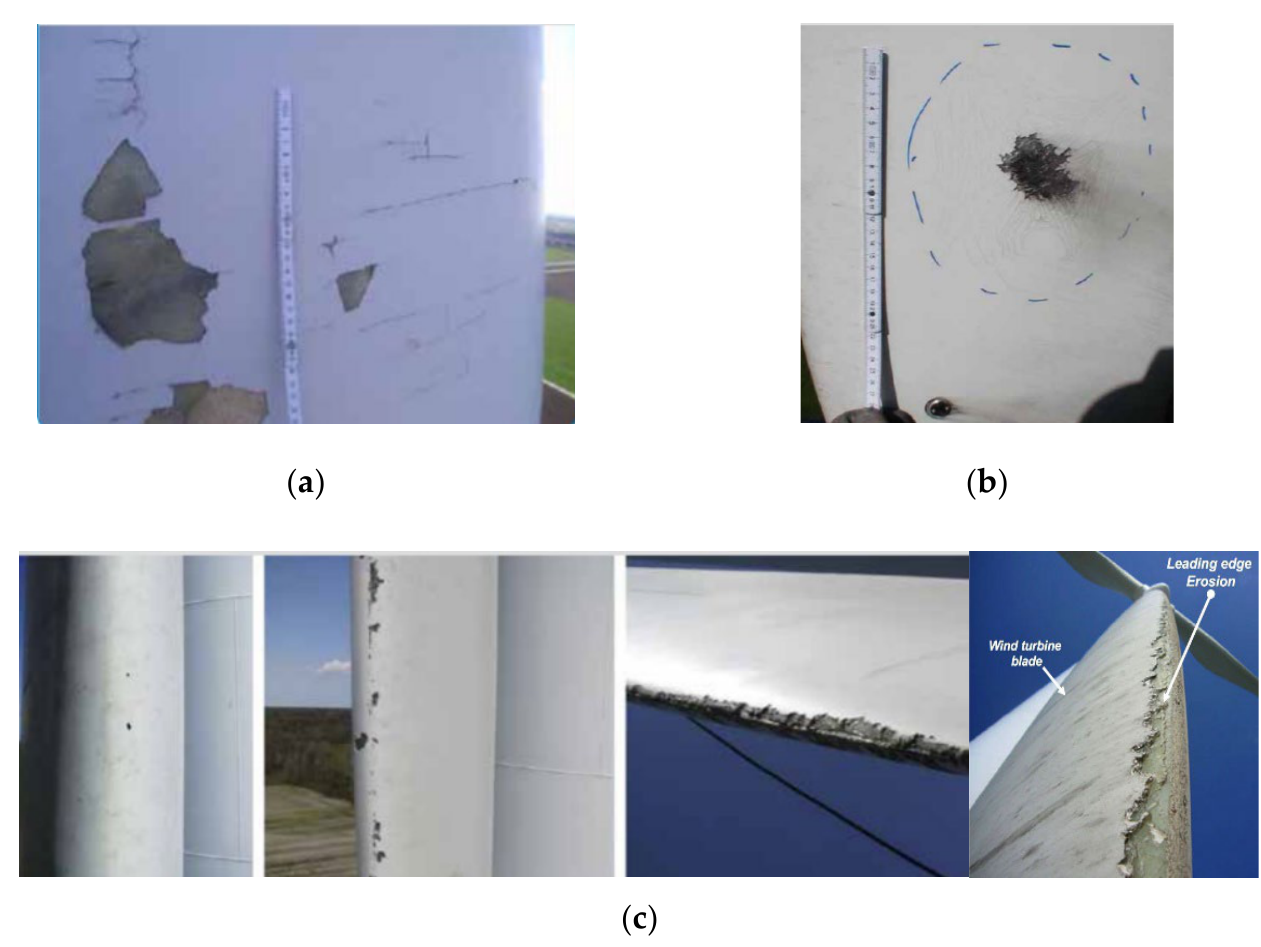
Figure 7. ( a ) Cracks and peeling in gelcoat [30], ( b ) Damage caused by lightning [30], ( c ) Evolution of leading-edge erosion by normal wear [31].